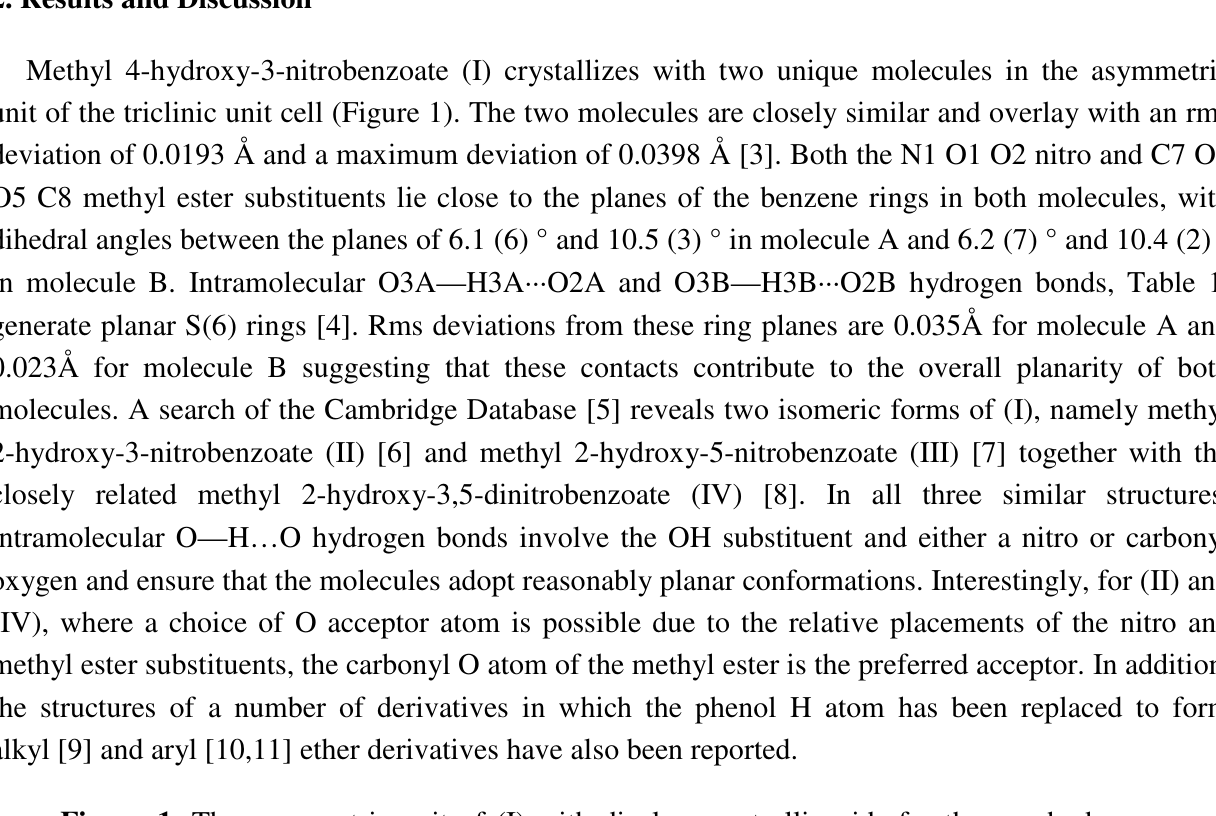
Figure 1. The asymmetric unit of (I) with displacement ellipsoids for the non-hydrogen atoms drawn at the 50% probability level, and intramolecular hydrogen bonds are drawn as dashed lines in molecules A and